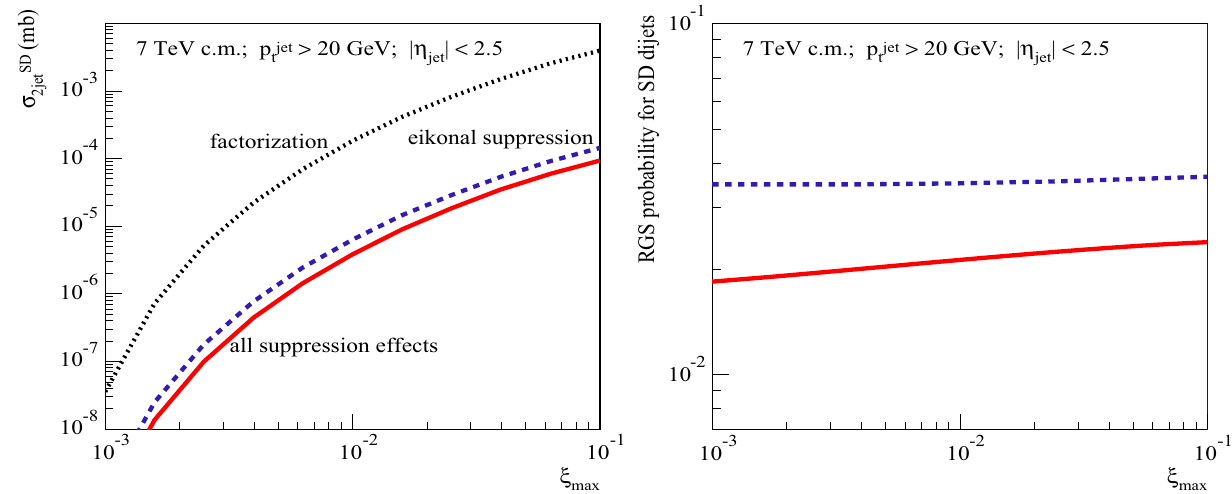
− SD ( fact ) σ 2jet − SD ( eik ) σ 2jet − SD pp (dotted), pp (dashed), and pp (solid). Right: √ = 20 GeV/c, and 2 s = 7 TeV, p cut (dashed) and S 2 (solid). All for t SD ( eik ) SD ( tot )